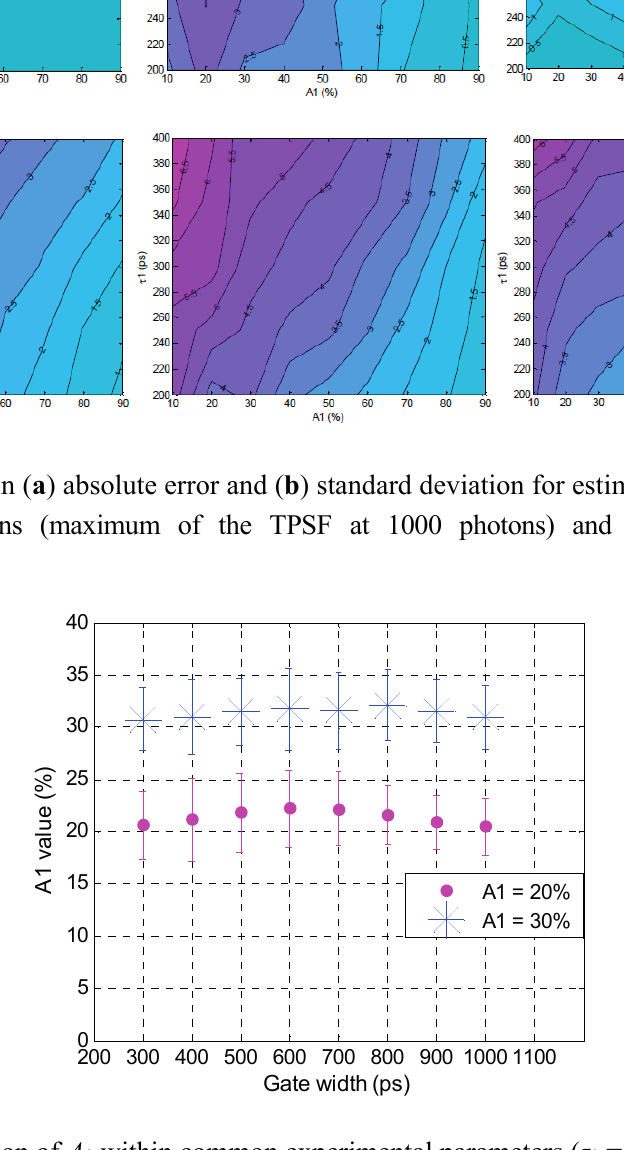
Figure 4. Estimation of A 1 within common experimental parameters ( τ 1 = 300 ps, A 1 = 20% and A 1 = 30%, maximum photon counts =